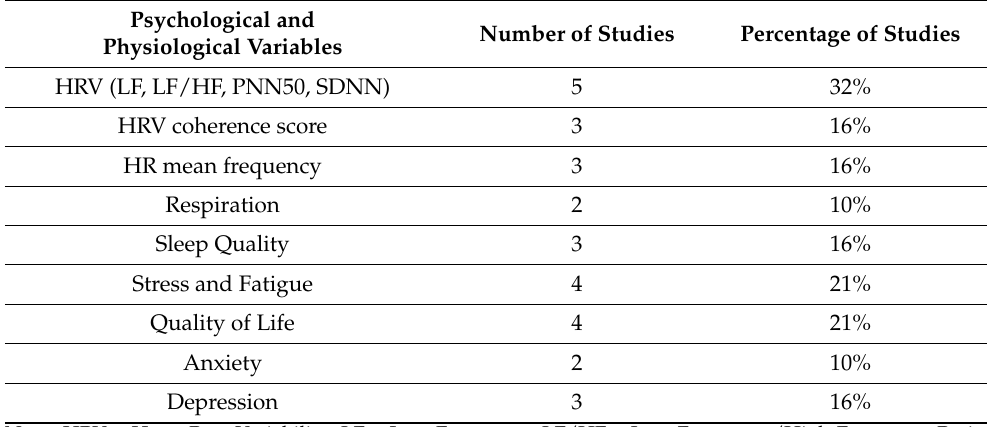
Table A1. Frequencies of Reported Outcomes in Selected Empirical and Theoretical Studies.